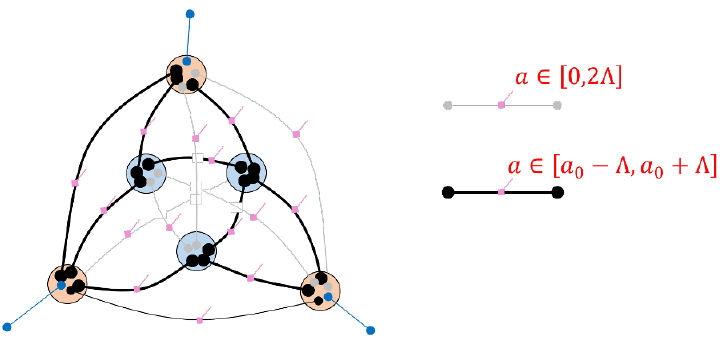
Figure 6 . Illustration of small (cid:13)uctuations around a classical geometry. In the classical geometry, the black thick lines and grey thin lines are connected links with a xy = a 0 and disconnected links with a xy = 0, respectively. The (cid:13)uctuations are encoded by (cid:13)uctuation of link quantum number a around the classical value in a small